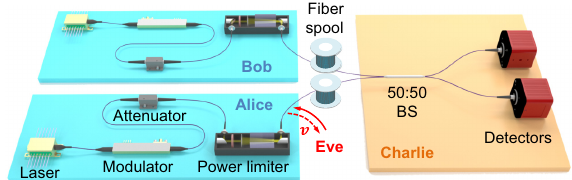
FIG. 6. Schematic of the phase-encoding MDI-QKD [37] sys- tem with the power limiter installed. For each round, using their lasers, modulators, and attenuators, Alice and Bob prepare one of the four coherent states {| α e ix π/ 2 (cid:3)} x and {| β e iy π/ 2 (cid:3)} y , where x , y ∈ { 0, 1, 2, 3 } . They would then send their respective quan- tum states to Charlie for Bell-state measurement, who would then announce the outcome of his measurement z ∈ { L , R , ∅ } . If Charlie announces z = ∅ , they would discard the data for that round; otherwise, they would keep their respective choices x and y . After many rounds, they perform sifting and parameter estima- tion, and if they do not abort the protocol, they will also perform error correction and privacy amplification to extract identical and secret keys. Based on the power limiting threshold, the Trojan- horse attack from Eve could provide her with an average of ν Trojan-horse photons per pulse, which is taken into consideration for secure key rate